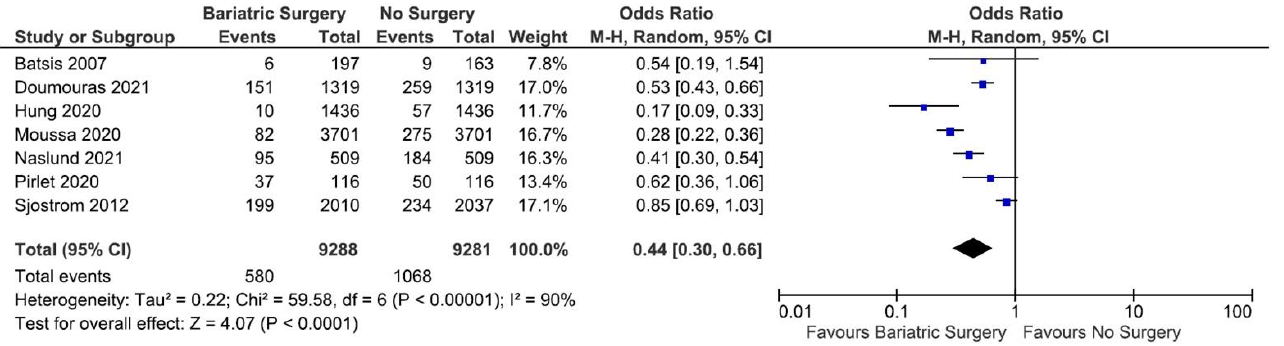
Figure 6. Forest plot of the MACE incidence comparing bariatric surgery with no surgery excluding studies with an unequal sample size between the arms.